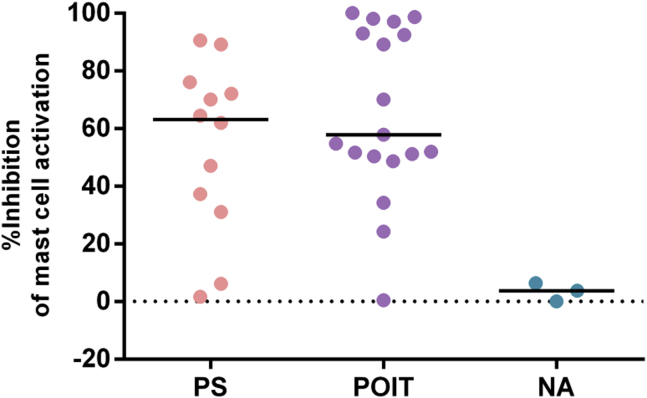
Inhibition of peanut-induced mast cell activation in the presence of plasma from PS patients with detectable P-sIgG4 levels (n = 12) and from patients submitted to POIT (n = 19) but not in the presence of plasma from NA subjects (n = 3). Cells were stimulated with 10 ng/mL peanut extract. Inhibition was tested against the same plasma of a patient with PA. % Inhibition = (% CD63+ cells sensitized with plasma from a patient with PA − % CD63+ cells sensitized with plasma from a patient with PA in the presence of test plasma)/% CD63+ cells sensitized with plasma from a patient with PA. POIT, Patients with PA who underwent POIT (ie, samples collected >6 months after treatment).